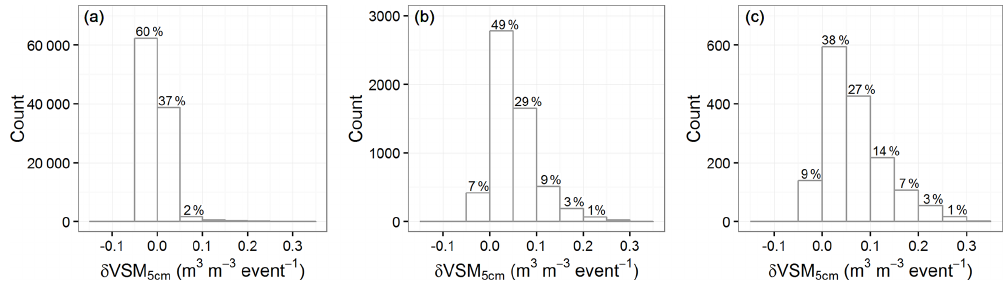
Figure 9. Statistical distribution of δ VSM 5cm for 104178 fully documented rainfall events (a) , 5714 marked rainfall events (b) , and 1577 marked rainfall events affecting topsoil temperature (c) defined in Table